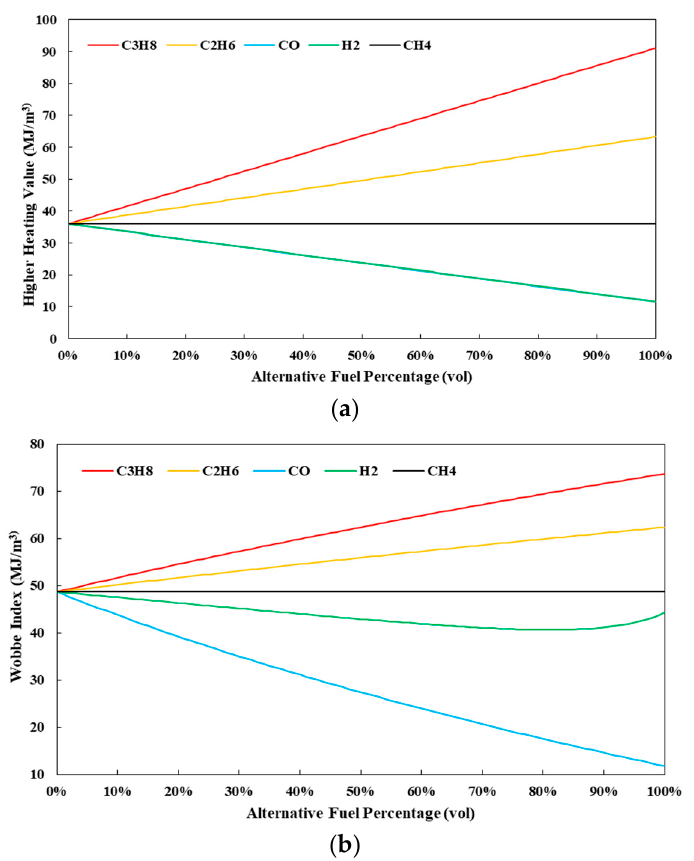
Figure 15. HHV and WI of methane/alternative fuel mixtures. ( a ) Higher heating value of methane/alternative fuel mixtures. ( b ) Wobbe Index of methane/alternative fuel